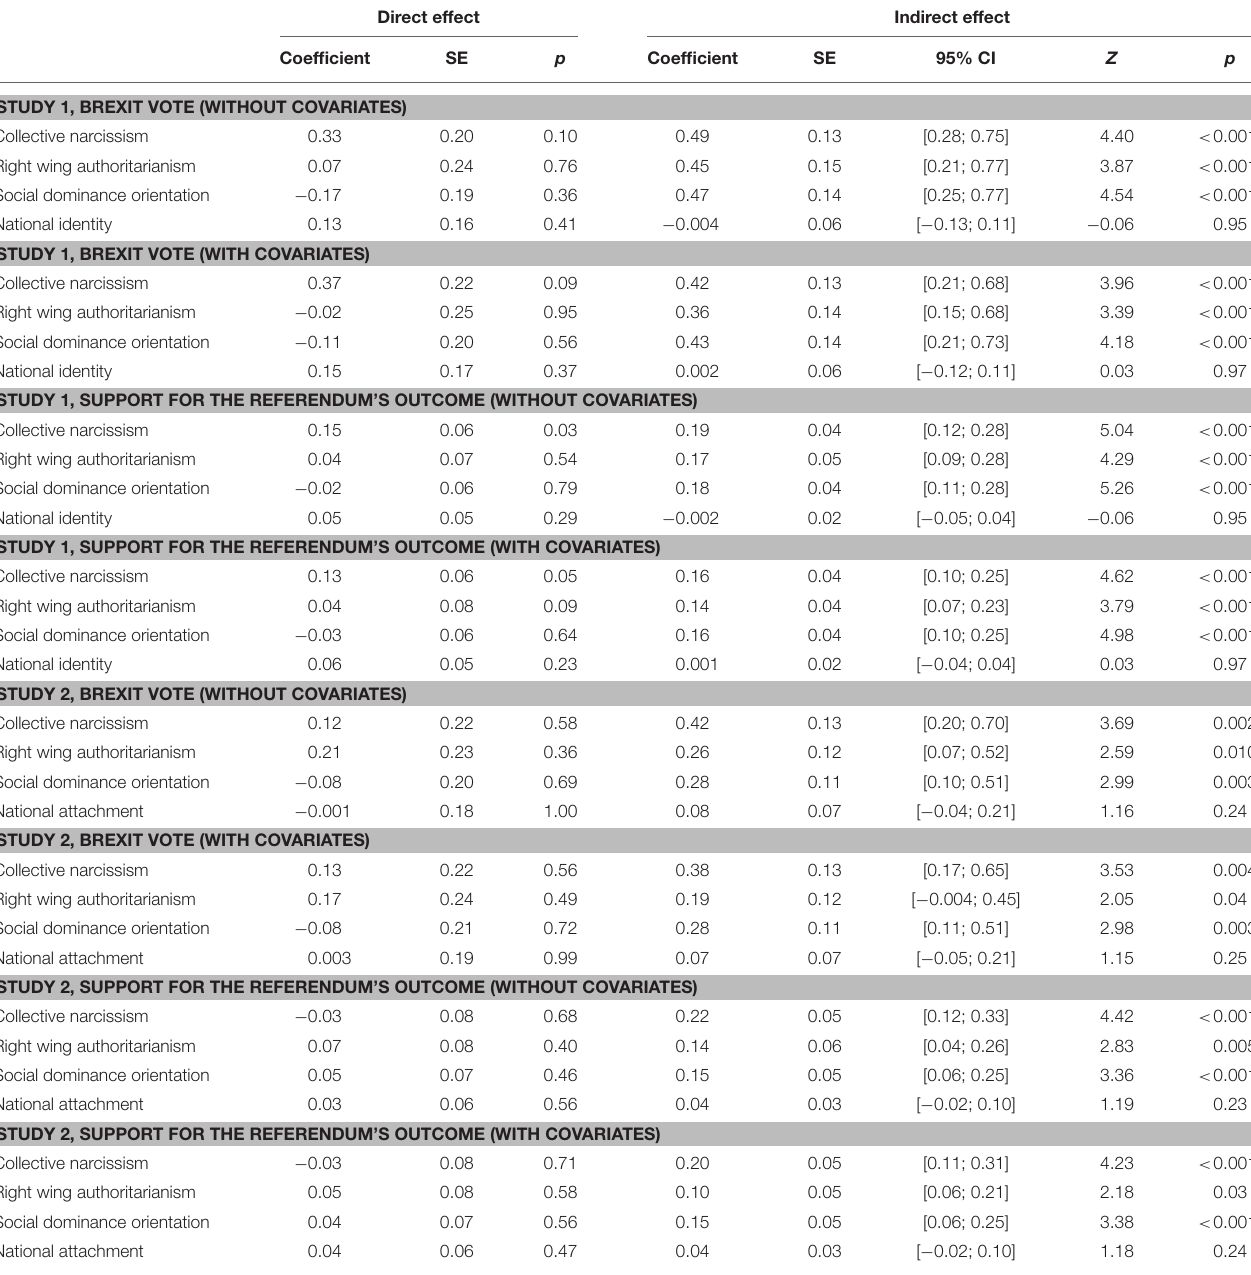
TABLE 2 | Direct and indirect effects of all variables on the Brexit vote and support for the referendum’s outcome, Study 1 and